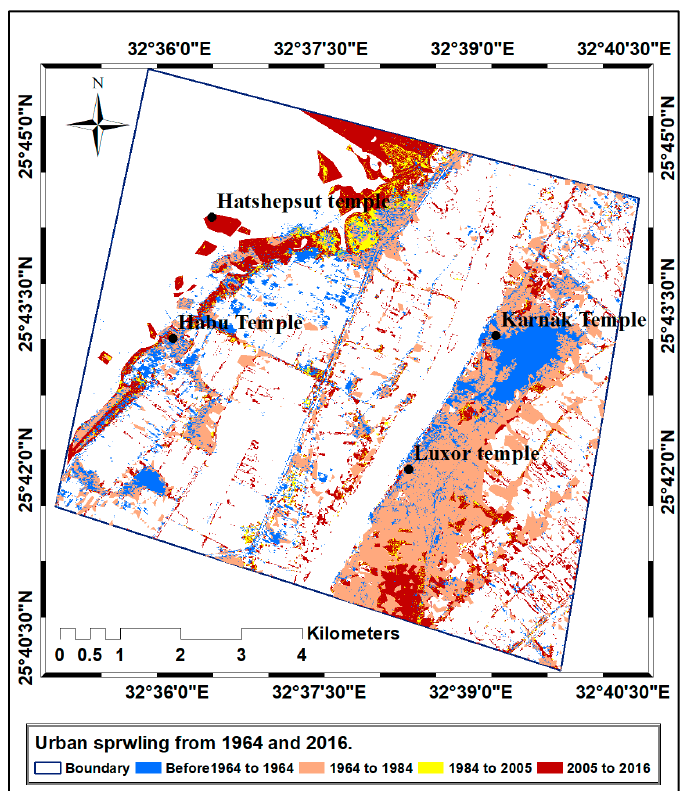
Figure 12. Changes in the urban area between 1964 and 2016.